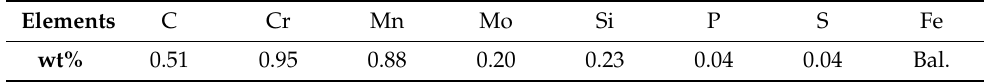
Table 1. Chemical composition (in wt%) of 50CrMo4 steel used.